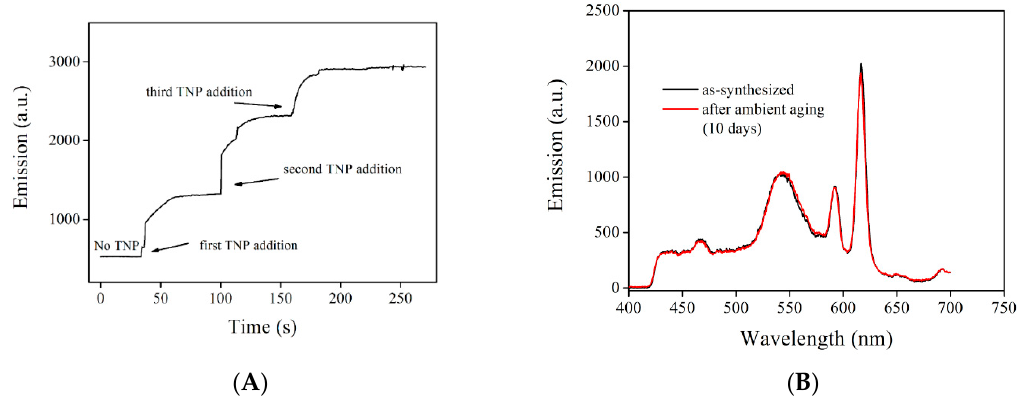
Figure 8. ( A ) RS6h@EuBTC emission intensity (552 nm) monitoring by dropwise addition of TNP; ( B ) Emission spectra of RS6h@EuBTC before and after ambient aging (10